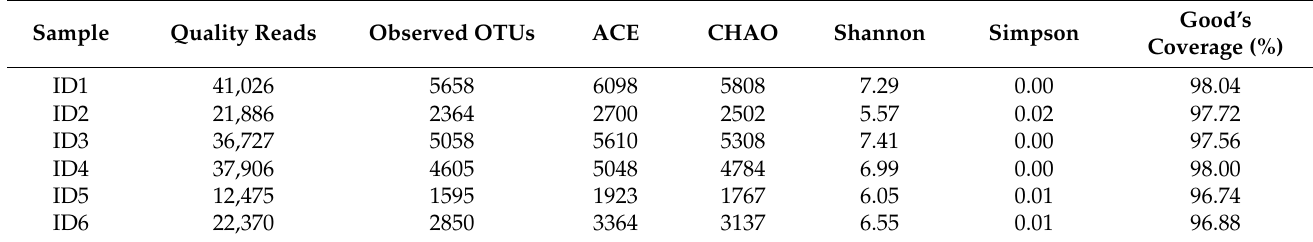
Table 2. Alpha diversity indices for bacterial communities in the different dump site